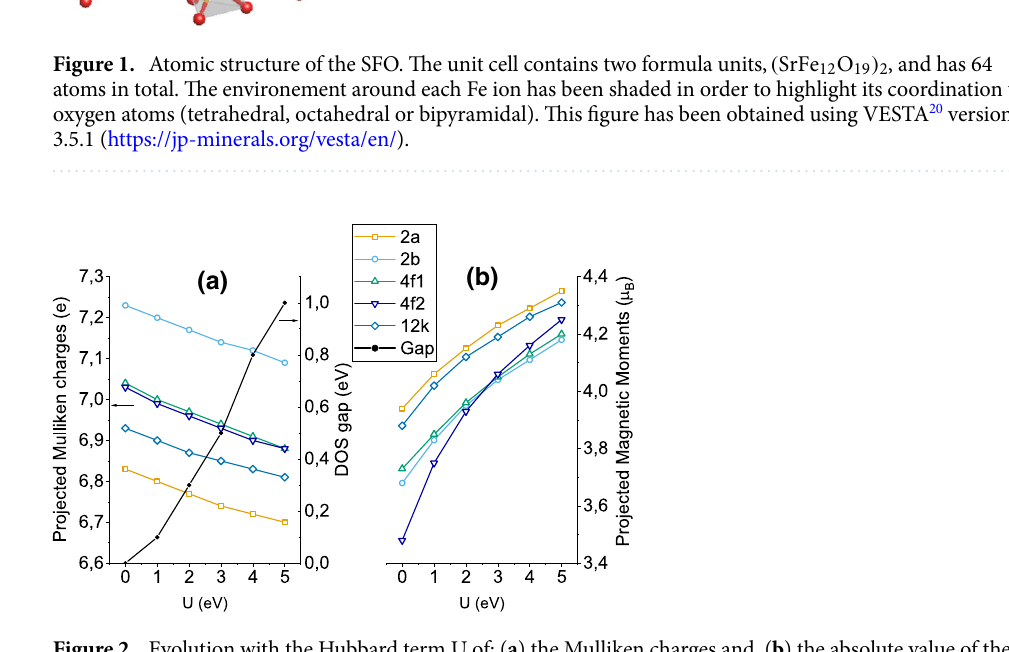
Figure 2. Evolution with the Hubbard term U of: ( a ) the Mulliken charges and, ( b ) the absolute value of the MMs, projected on the Fe sublattices. In ( a ) the dark line shows additionally the calculated SFO band gap (right y